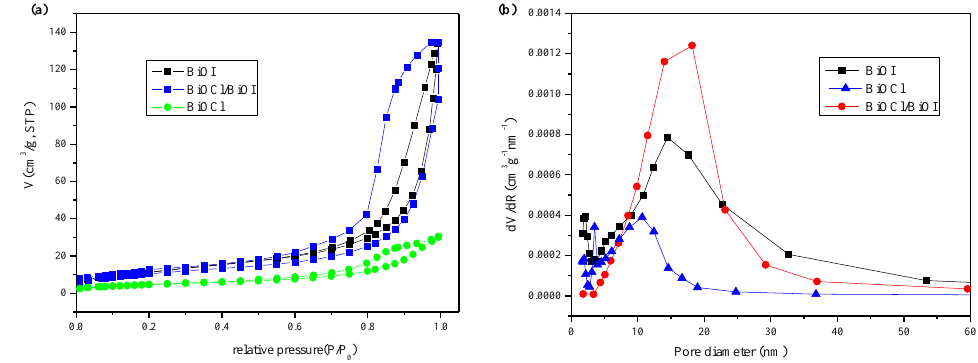
Figure 6. ( a ) Nitrogen sorption isotherms of BiOI, BiOCl, and BiOI/BiOCl; ( b ) Pore size distributions of BiOI, BiOCl, and BiOI/BiOCl. Table 2. The Brunauer-Emmett-Teller (BET) surface areas and pore structures of the